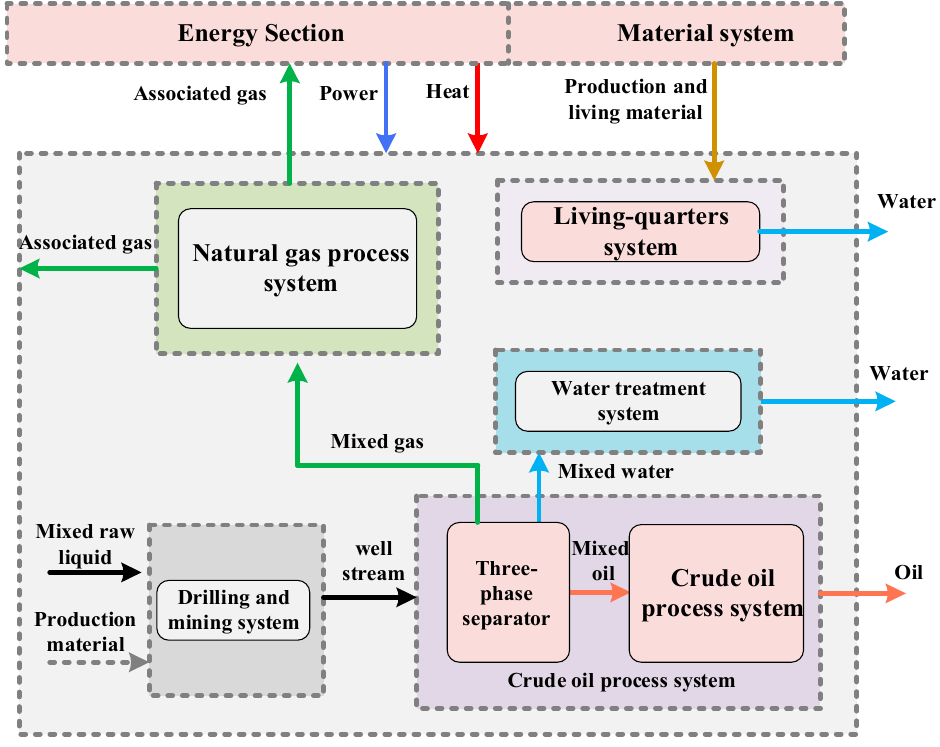
Figure 5. Schematic diagram of OEPS.